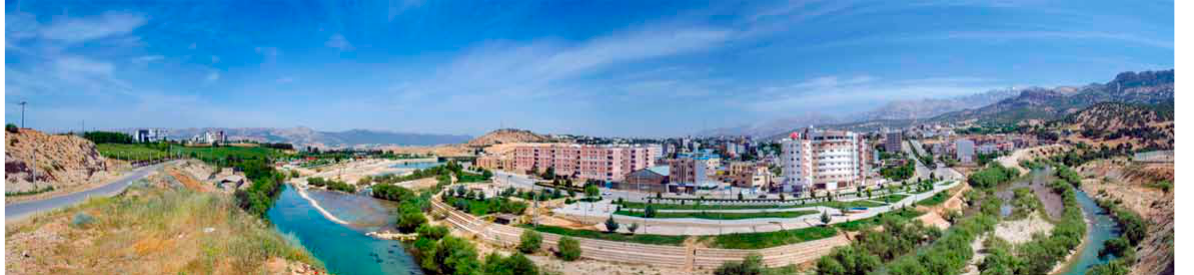
fig. 5. Southern view of Yasouj panorama (photo by the